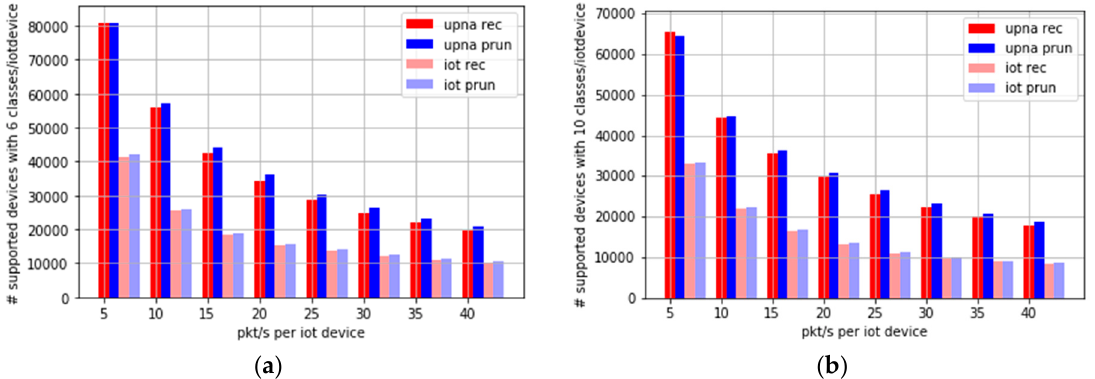
Figure 15. Number of devices supported, depending on the traffic generated per IoT device ( a ) extracting 6 time series per device, or ( b ) extracting 10 time series per device.